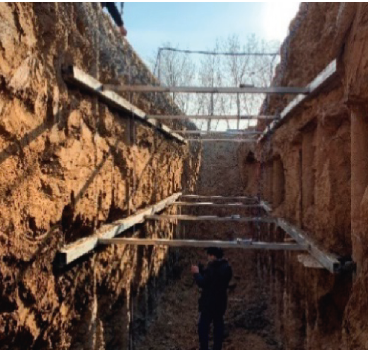
Figure 5: Supporting structure.